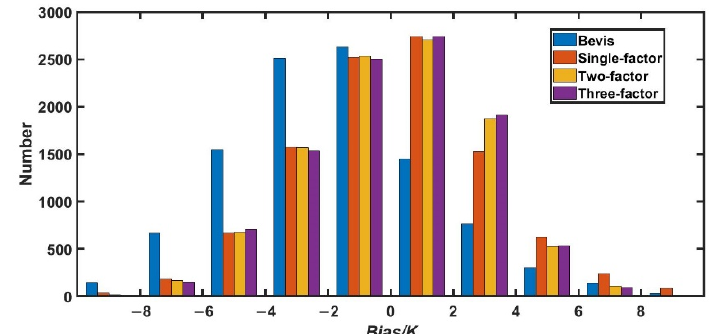
Figure 3. Bias statistical histograms of Bevis model and yearly one-factor, two-factor and three- factor RTMs.